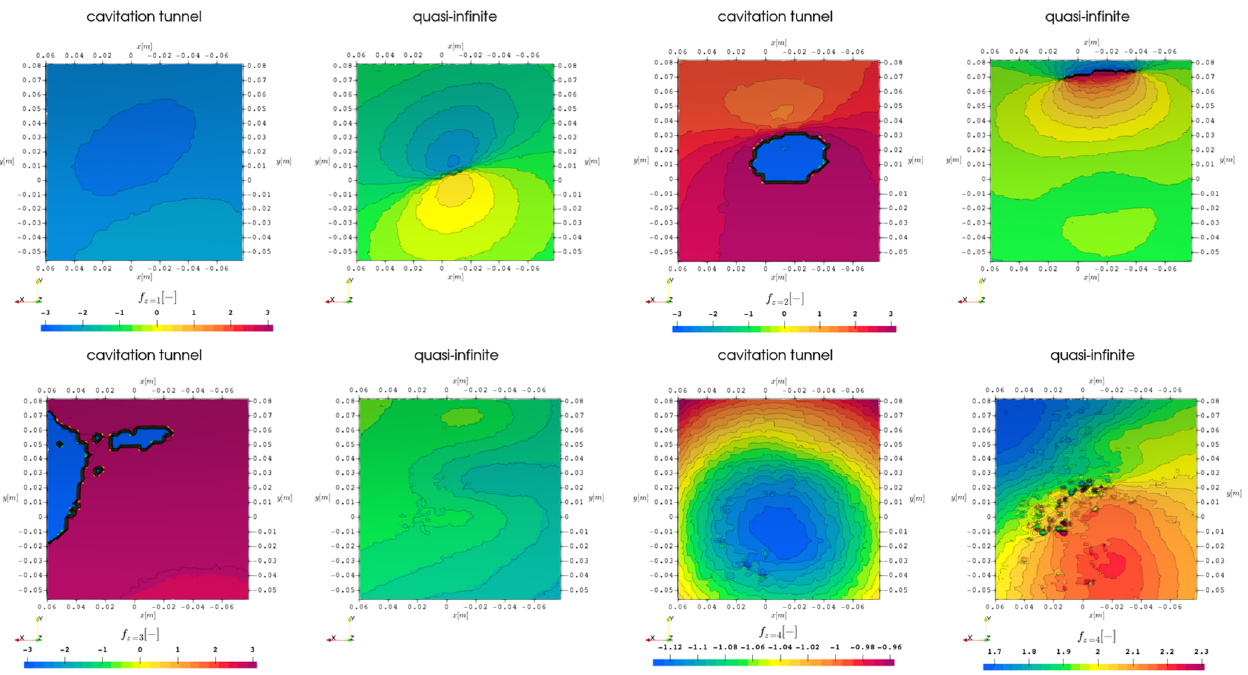
Figure 8. Phase information on hull at the first 4 harmonic propeller blade harmonic frequencies, comparison of domain extent, RANS with cavitation.